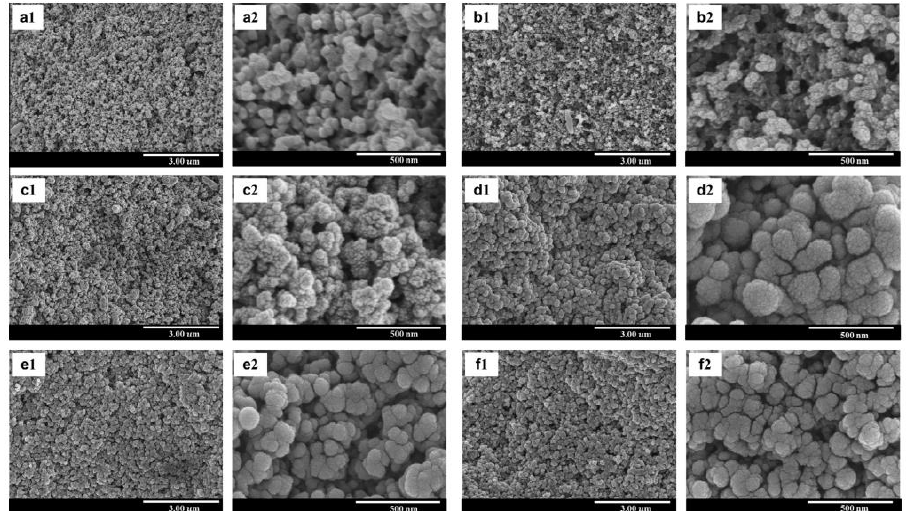
Figure 23. SEM images with low magnification ( 1 ) or high magnification ( 2 ) of CTAB added at concentrations of ( a ) 0 M, ( b ) 0.003 M, ( c ) 0.009 M, ( d ) 0.030 M, ( e ) 0.090 M, and ( f ) 0.180 M (reproduced from the work in [36] with permission).